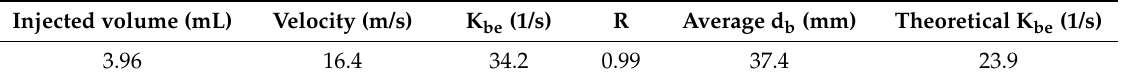
Table 3. Experimental bubble-to-emulsion mass transfer coefficients.